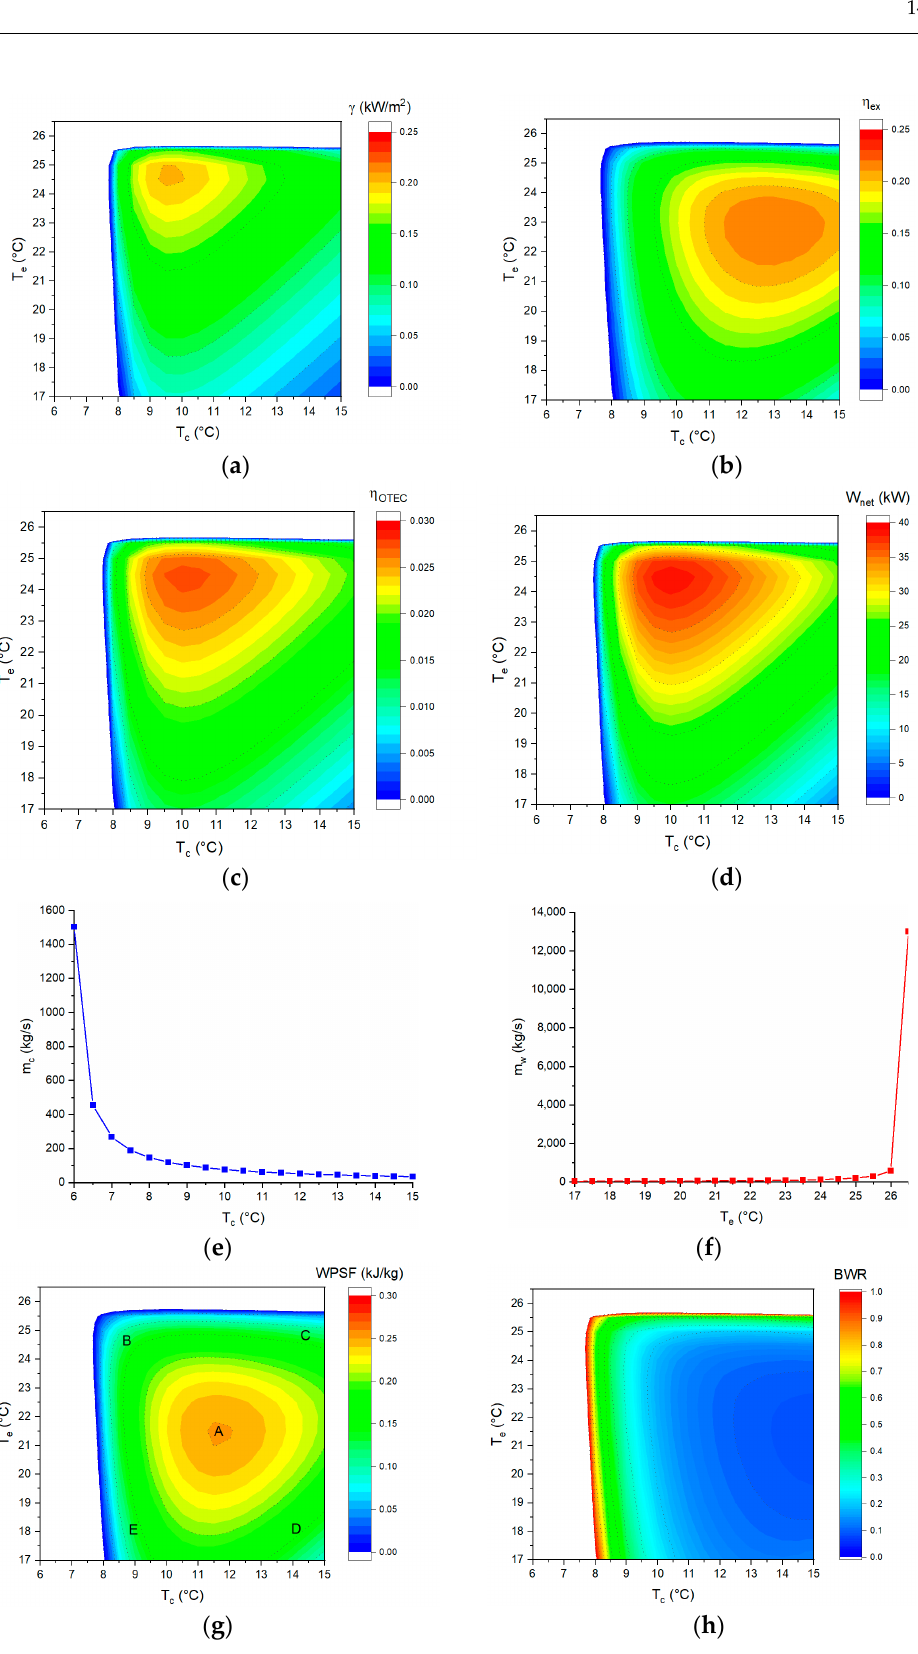
denser ( 𝑄 (cid:3032) + 𝑄 (cid:3046)(cid:3030) and 𝑄 (cid:3030) + 𝑄 (cid:3046)(cid:3035) ) all remain unchanged, no matter how the pinch-point tem- perature difference changes. The parameters directly related to the pinch-point tempera- ture difference are mainly the flow rate of the seawater, the area of the heat exchanger, and the seawater pump power consumption. From Figure 10a,b, it can be seen that the larger the pinch-point temperature differ- ence is, the smaller the heat exchanger area is but the higher the seawater consumption is. Seawater pump power is proportional to seawater flow rate. From Figure 10c–h, it can be seen that the effects of ∆𝑇 (cid:3050) and ∆𝑇 (cid:3030) on the net output power per unit area ( γ ) are different from those of the other terms. This is because only the net output power per unit area is related to both seawater flow rate and heat transfer area. The other terms are only related to seawater flow rate. This results in all of the per- formance parameters except the net output power per unit area decreasing as the pinch- point temperature difference increases.